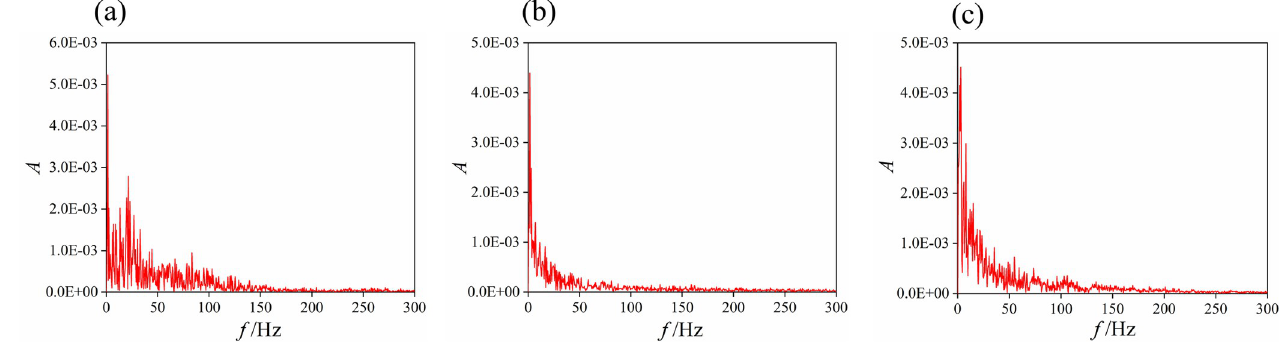
Fig 9. Frequency spectrum of the lift coefficient. (a) 10% opening. (b) 50% opening. (c) 100% opening.